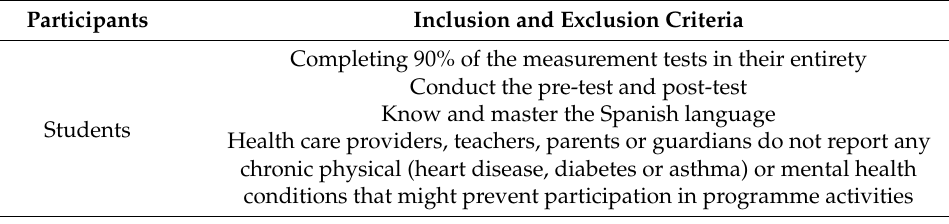
Table 1. Inclusion and exclusion criteria for students and